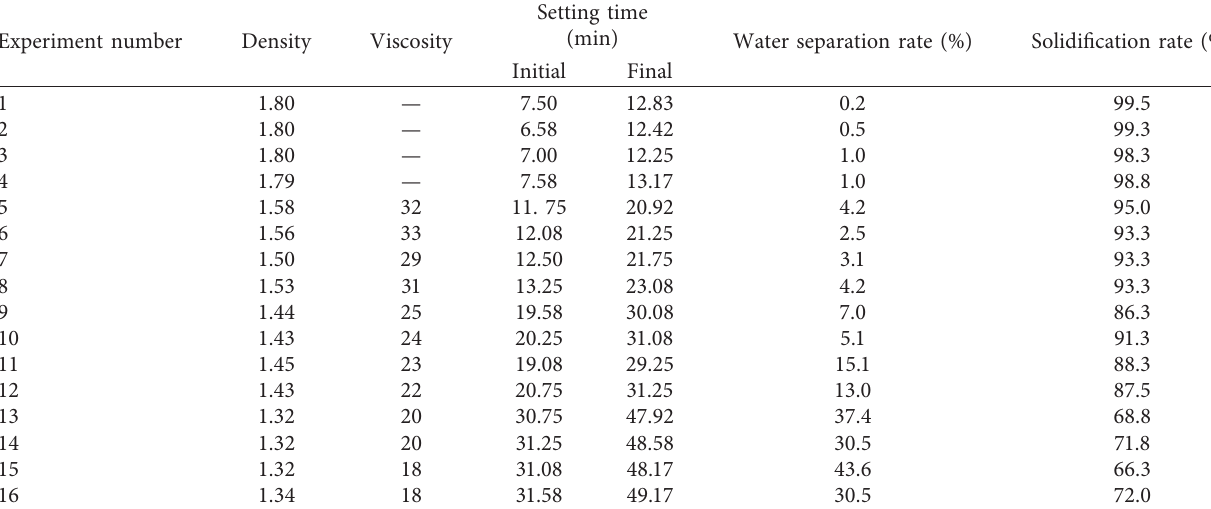
Table 7: Results of the orthogonal experiment.